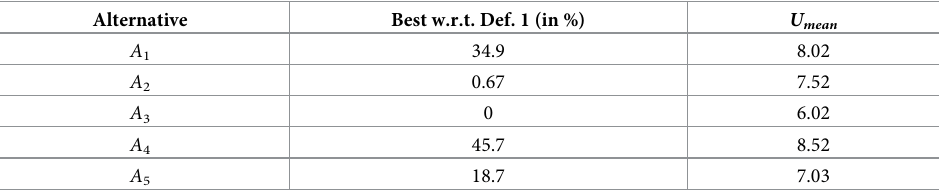
Table 2. Alternatives’ evaluation with respect to Definitions 1 and